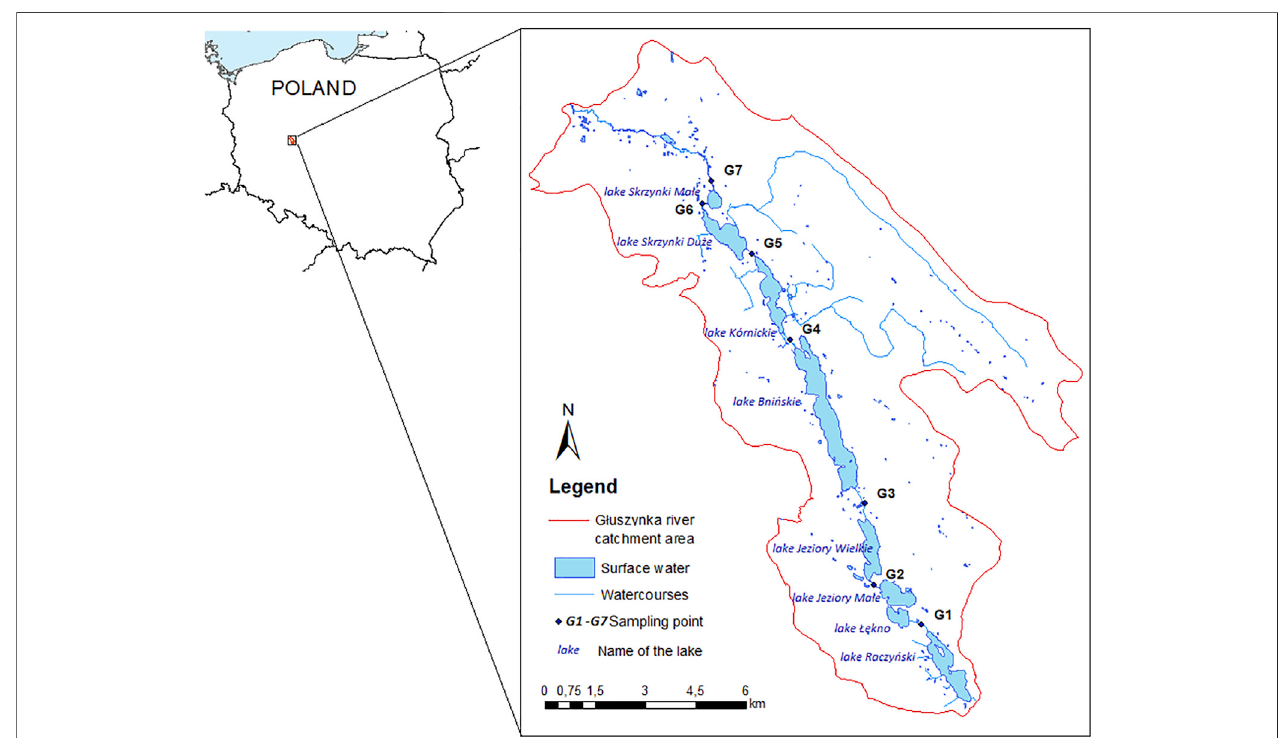
FIGURE 1 | Study site